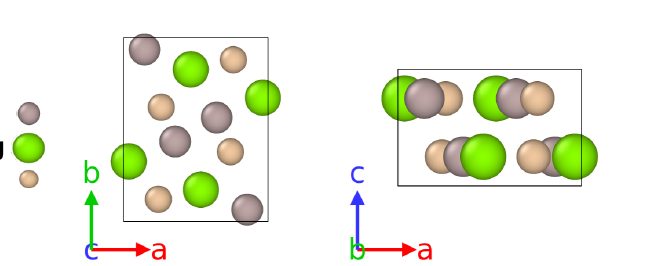
Figure 3. (Colour online). The relaxed unit cell of β (cid:48) with 2/3 Si occupancy of the 00 z Si sites, as established by Visser et al. [14].